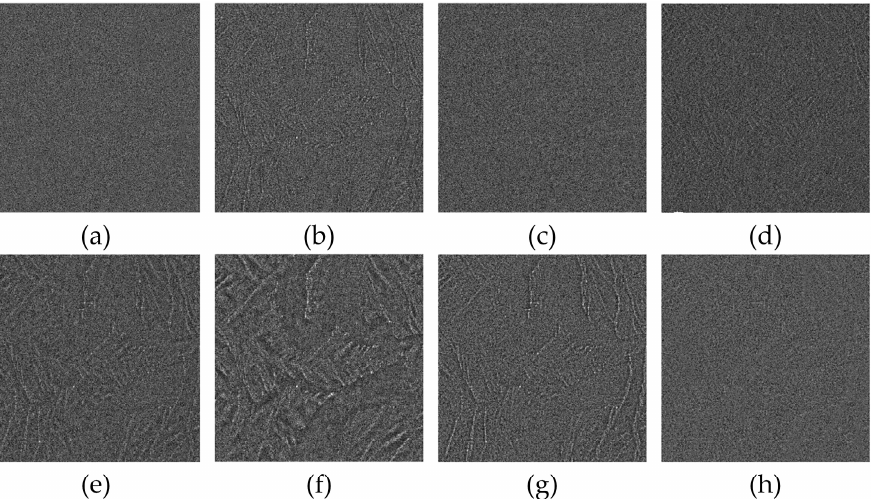
Figure 15. Ratio images between noisy and filtered ALOS-2 SAR images using ( a ) DPAD, ( b ) En- Lee, ( c ) SAR-BM3-D, ( d ) FANS, ( e ) PPB, ( f ) DnCNN, ( g ) NL-means, and ( h ) MDLPIA-NLM filters.